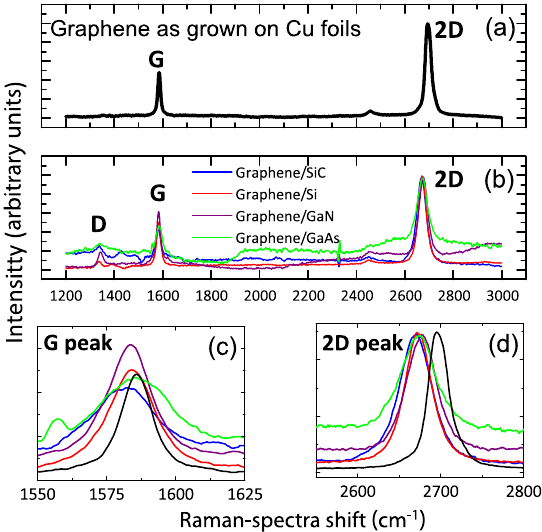
FIG. 2. Raman spectra of (a) CVD-grown graphene on Cu foils and (b) graphene, after transfer onto various semiconductor =I substrates. Graphene sheets show a large I G ratio, and after 2 D the transfer, the graphene becomes slightly disordered. (c) The Raman-spectra G peak. The black curve is the measurement on graphene/Cu and the other curves are for the graphene/semicon- ductor combinations as indicated in the legend in (b). (d) Same as in (c) for the Raman-spectra 2 D